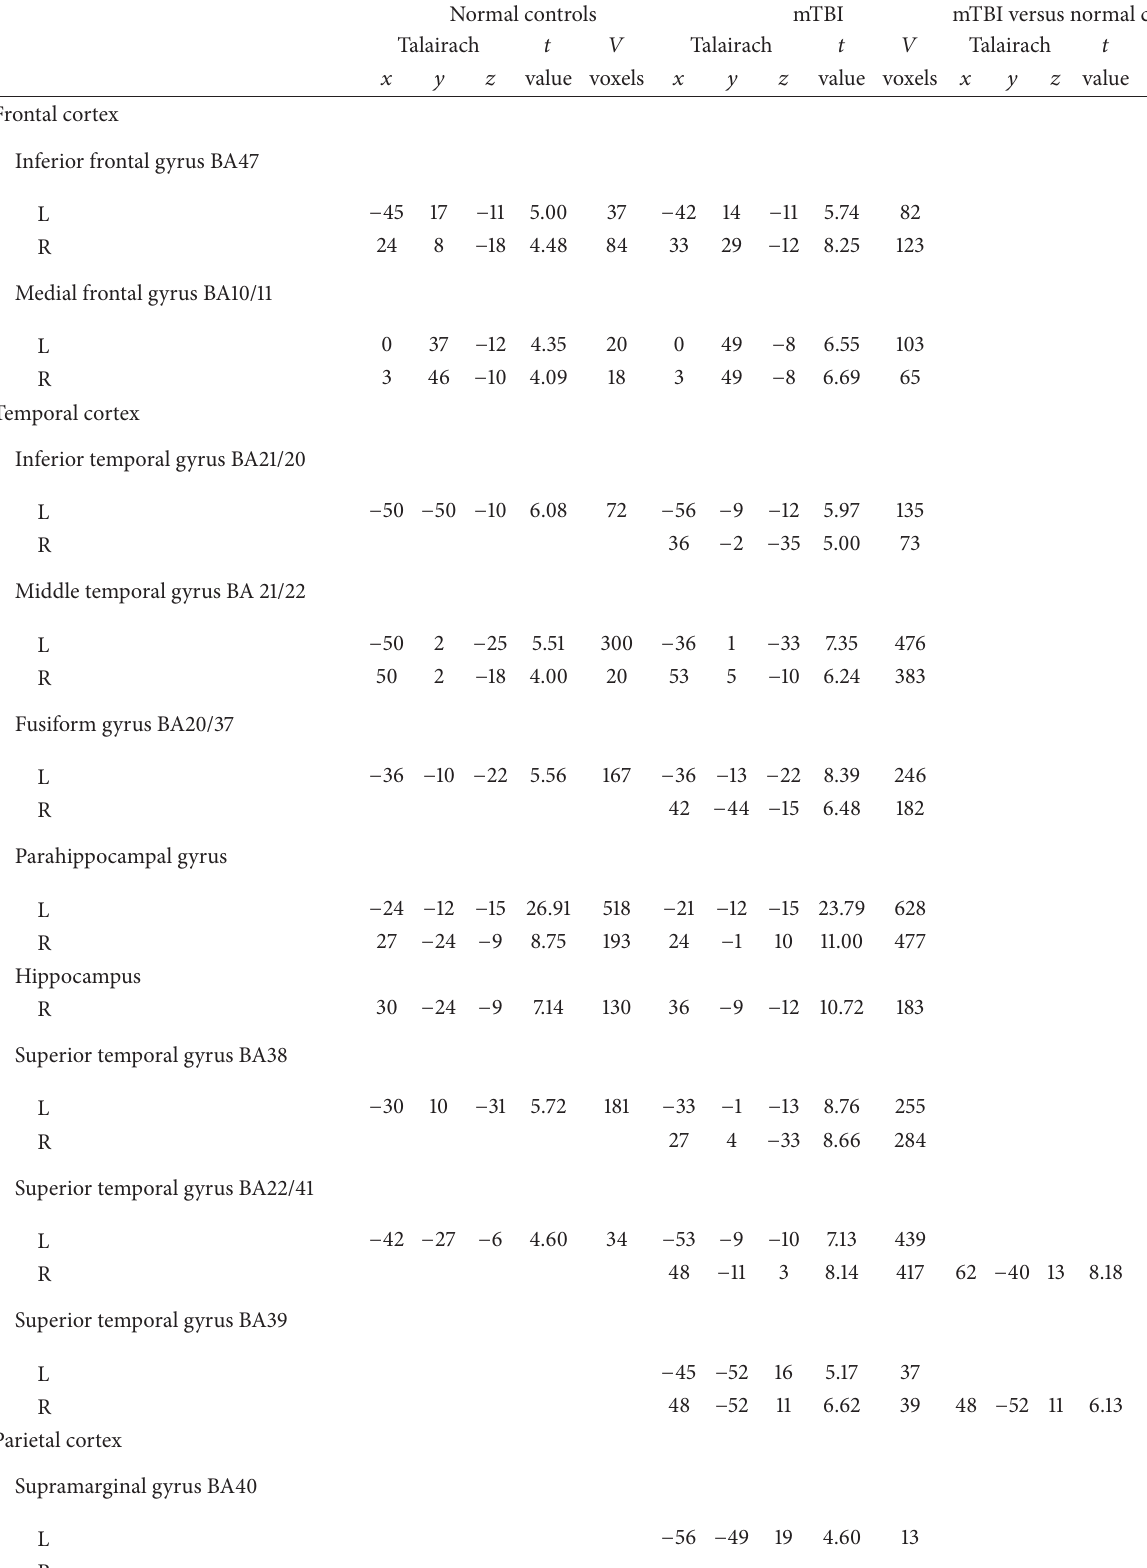
Table 1: Functionally connected brain areas with the left hippocampus in normal controls and mTBI survivors (voxel level: 𝑝 < 0.05 , FDR